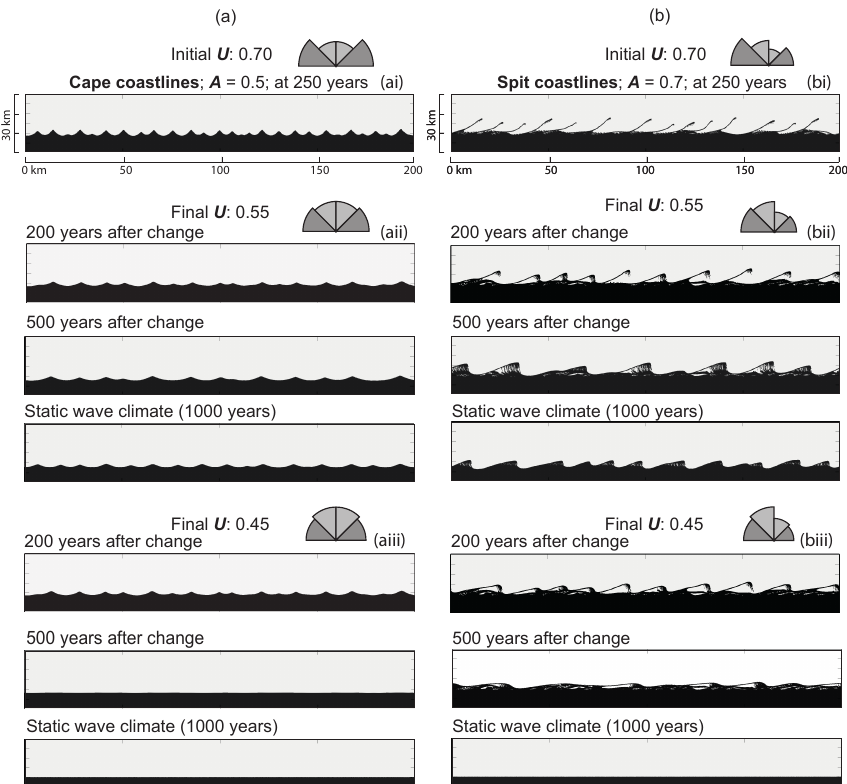
Figure 3. Snapshots of simulated coastline morphologies evolved under changing wave climate. See Section 3.1.3 onwards for discussion. (ai–iii) Capes evolved under a symmetric wave climate. (bi–iii) Spits evolved under an asymmetric wave climate. Horizontal and vertical scales are the same for all panels, representing a domain 30 × 200km. (ai, bi) Coastlines evolved for 250 years under initial conditions of U = 0 . 7 for A = 0 . 5 (capes) and 0.7 (spits). (aii, bii) The U values of the changed wave climate show the coastline morphologies evolved 200 and 500 years after the wave climate is changed at 250 years, and the morphologies evolved over 1000 years under static wave climates with the same U ; A values as the changed wave climate (note that in these examples, the wave climate is changed gradually over 100 years). The greater length scales in the morphologies of the coastlines altered by the changed wave climates are clear. The persistence of cross-shore amplitude for a spit coastline evolving under U of 0.45 is particularly evident. Model scales are the same in all panels. PDFs of the wave climates are included for